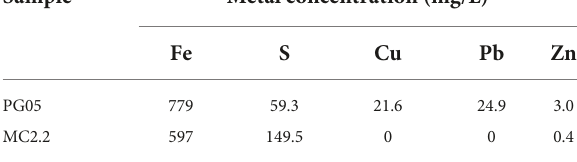
TABLE 3 Determination of the concentration of metals in sediment samples using ICP-EOS. Sample